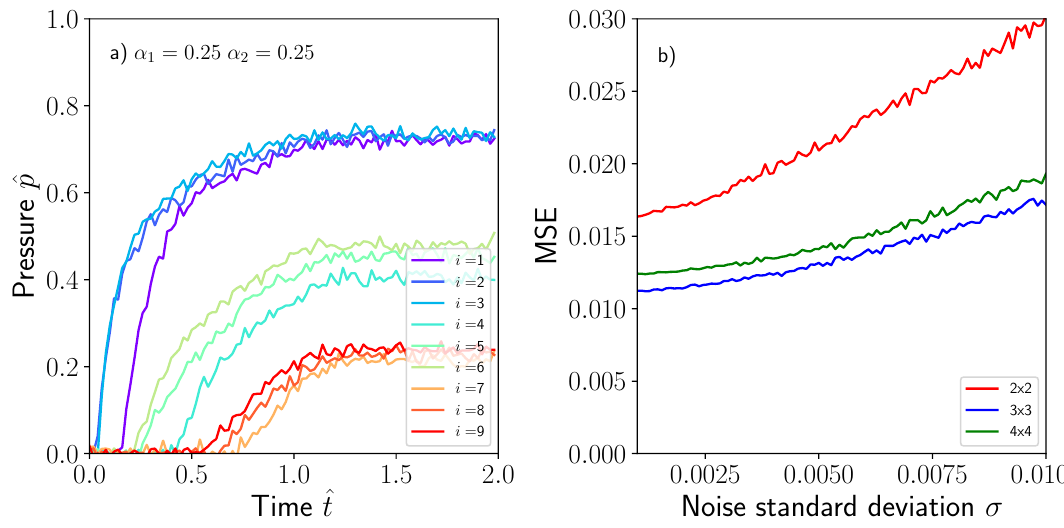
Figure 11. ( a ) Corrupted pressure signal with white noise following the Gaussian distribution N ( 0,0.01 ) , ( b ) MSE as a function of white noise standard deviation σ